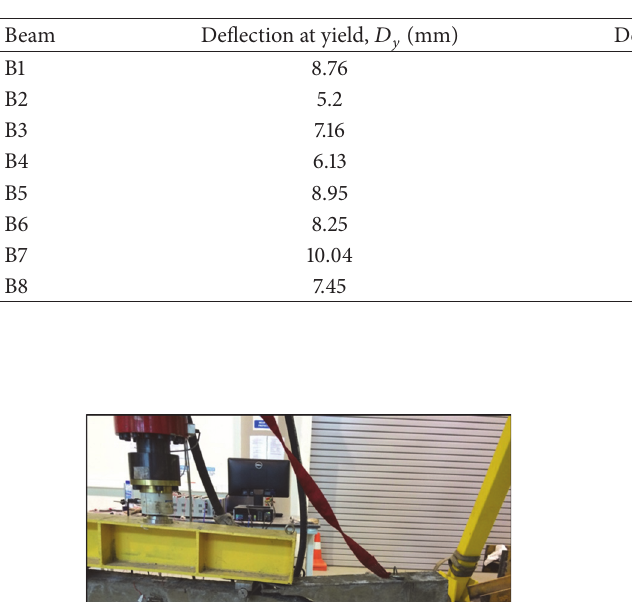
Table 8: Ductility ratio for R-SC-ECC beams (experimental results).